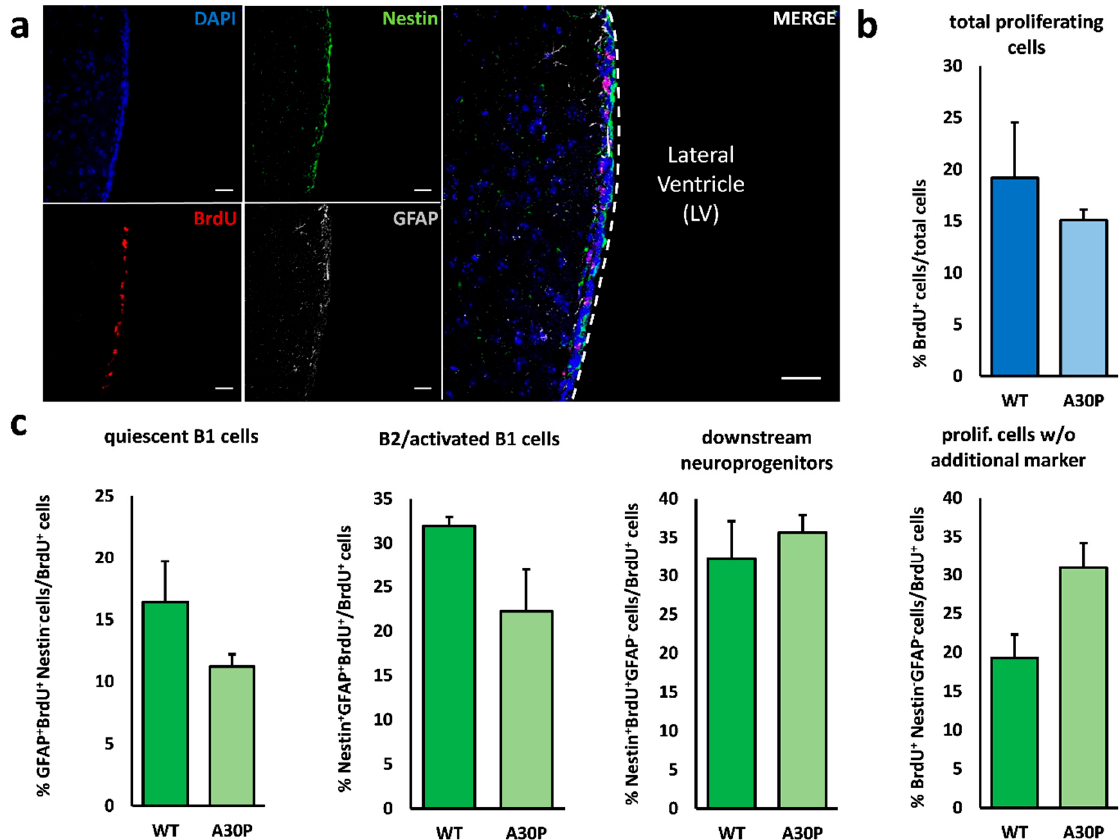
Figure 1. Neurogenesis in the V–SVZ of the Thy1-m[A30P]h α -synuclein mouse. ( a ) Representative fluorescence images of the ventricular–subventricular zone lining the lateral ventricle. Daily BrdU injections over 3 days labelled proliferating cells (red). To differentiate between the various cell types within the V–SVZ, quadruple immunostainings revealed GFAP + /nestin − (grey) quiescent type B1 cells, nestin + /GFAP − (green) type A and C cells (downstream neuroprogenitors) and GFAP + /nestin + B2/activated B1 cells. Cell nuclei were counterstained with DAPI (blue). ( b ) Quantitative immunohistochemistry revealed no difference in the total number of proliferating, i.e., BrdU-incorporating, cells between wild-type and m[A30P]h α -synuclein mice. ( c ) In addition, we analyzed the relative distribution of the proliferating cell types in the V–SVZ but found no significant differences between m[A30P]h α synuclein animals and controls, though a tendency towards a reduction in the relative amount of B2/activated B1 cells was noticed. The proportion of quiescent type B1 cells and downstream neuroprogenitor cells (type A and C cells) was unchanged. Scale bar = 50 μ m. All data are presented as mean ± standard error of the mean (S.E.M.); n = 3 each Abbreviations: LV—lateral ventricle; WT—wild-type; m[A30P]h— mutant human A30P α -synuclein mice; BrdU—bromodeoxyuridine; GFAP—glial fibrillary acidic protein; V–SVZ—ven- tricular–subventricular zone.